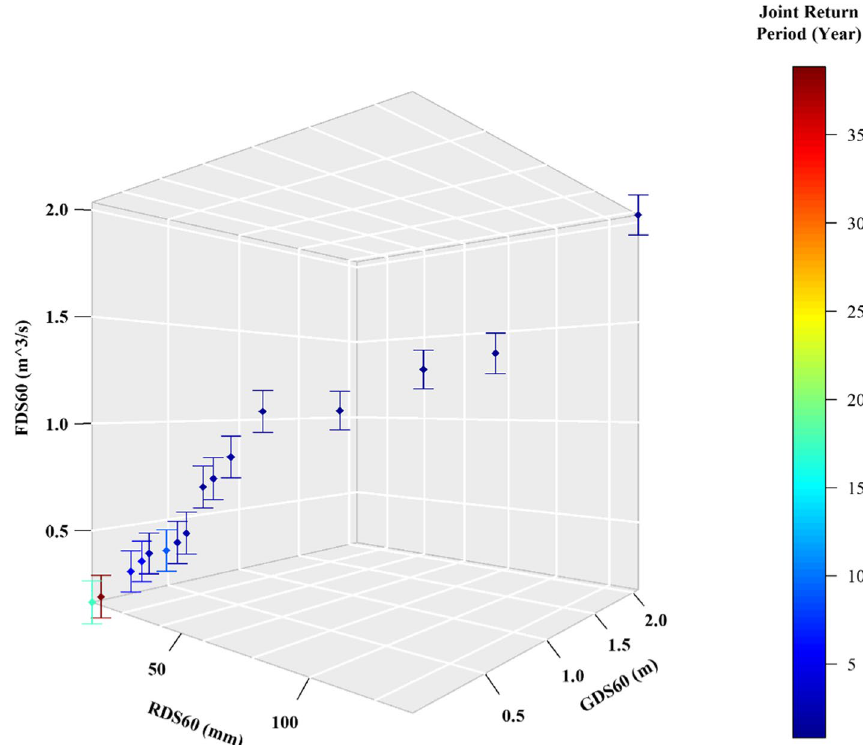
Fig. 10 Trivariate return period analysis of groundwater deficiency signature affected by river flow and rainfall defi- ciency signatures in "and" state for a 60-day